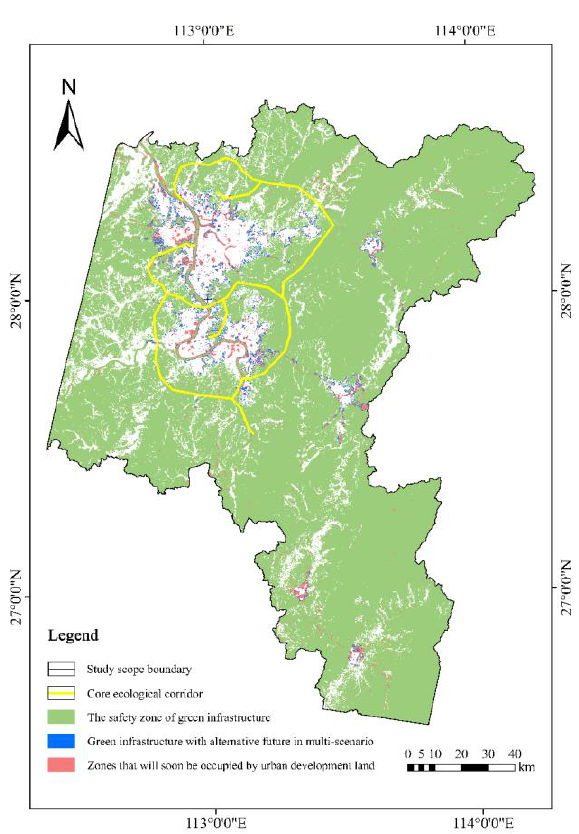
Figure 7. Different control areas of the green infrastructure.